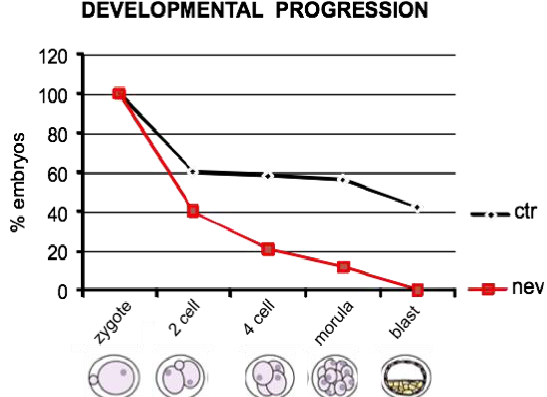
Figure 1. Nevirapine treatment arrests early mouse embryo development. The graphs represent the percentage of viable mouse embryos obtained from in vitro fertilization experiments in ordinary culture conditions (controls, ctr, black line) or in the presence of nevirapine (nev, red line), at each developmental stage (Modified from Pittoggi et al .,